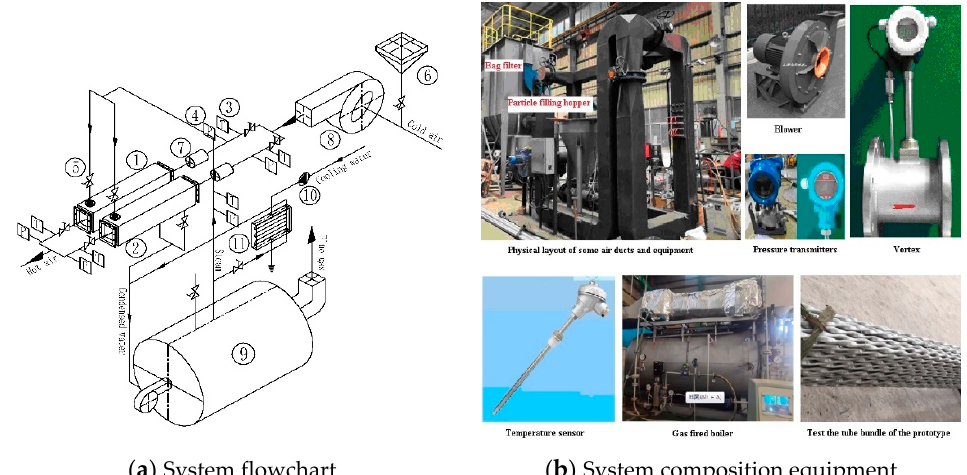
Figure 1. Flow chart of the heat exchanger test system. 1. Test prototype I; 2. test prototype II; 3. temperature sensor; 4. pressure transmitters; 5. control valve; 6. particle filling hopper; 7. vortex flowmeter; 8. blower; 9. gas-fired boiler; 10. booster pump; and 11. steam condenser.